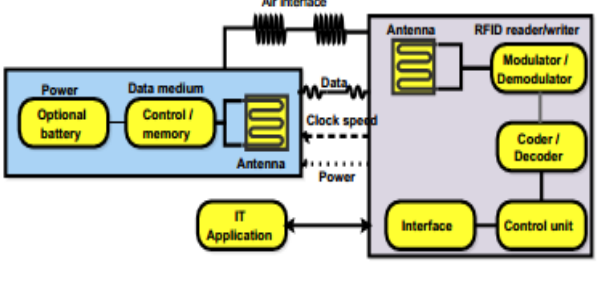
Figure 7. Working principle of RFID